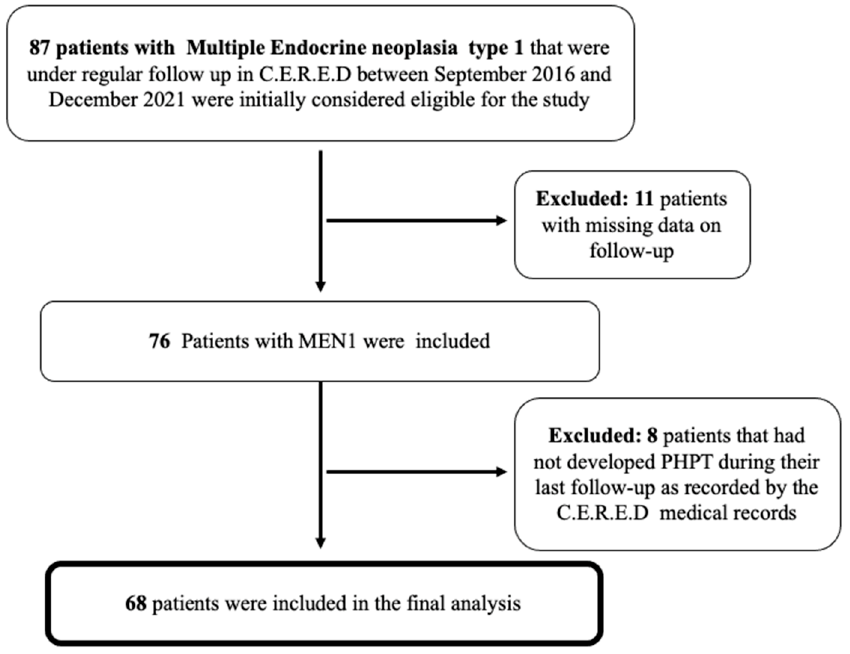
Figure 1. Flow chart of the finally included patients with MEN1-related PHPT that were under regular follow-up in our Centre (C.E.R.E.D). MEN1, Multiple Endocrine Neoplasia type 1; PHPT, primary hyperparathyroidism.